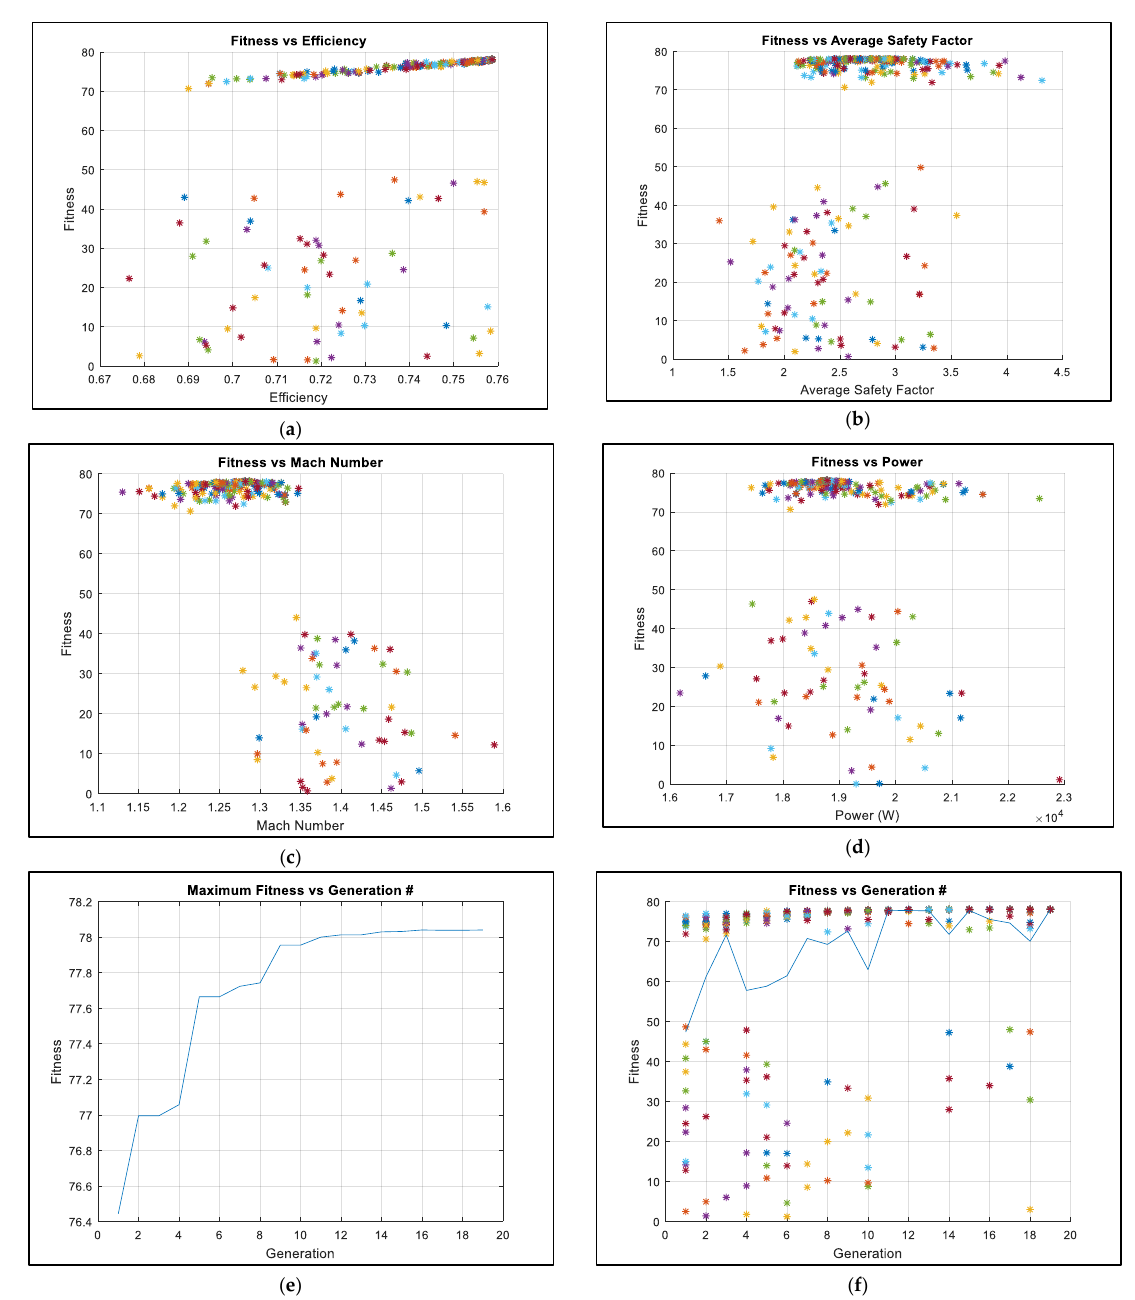
Figure 9. Design space exploration by ( a ) efficiency, ( b ) average safety factor, ( c ) Mach number, ( d ) power, ( e ) elite fitness vs. generation number, and ( f ) elite fitness vs. generation number.